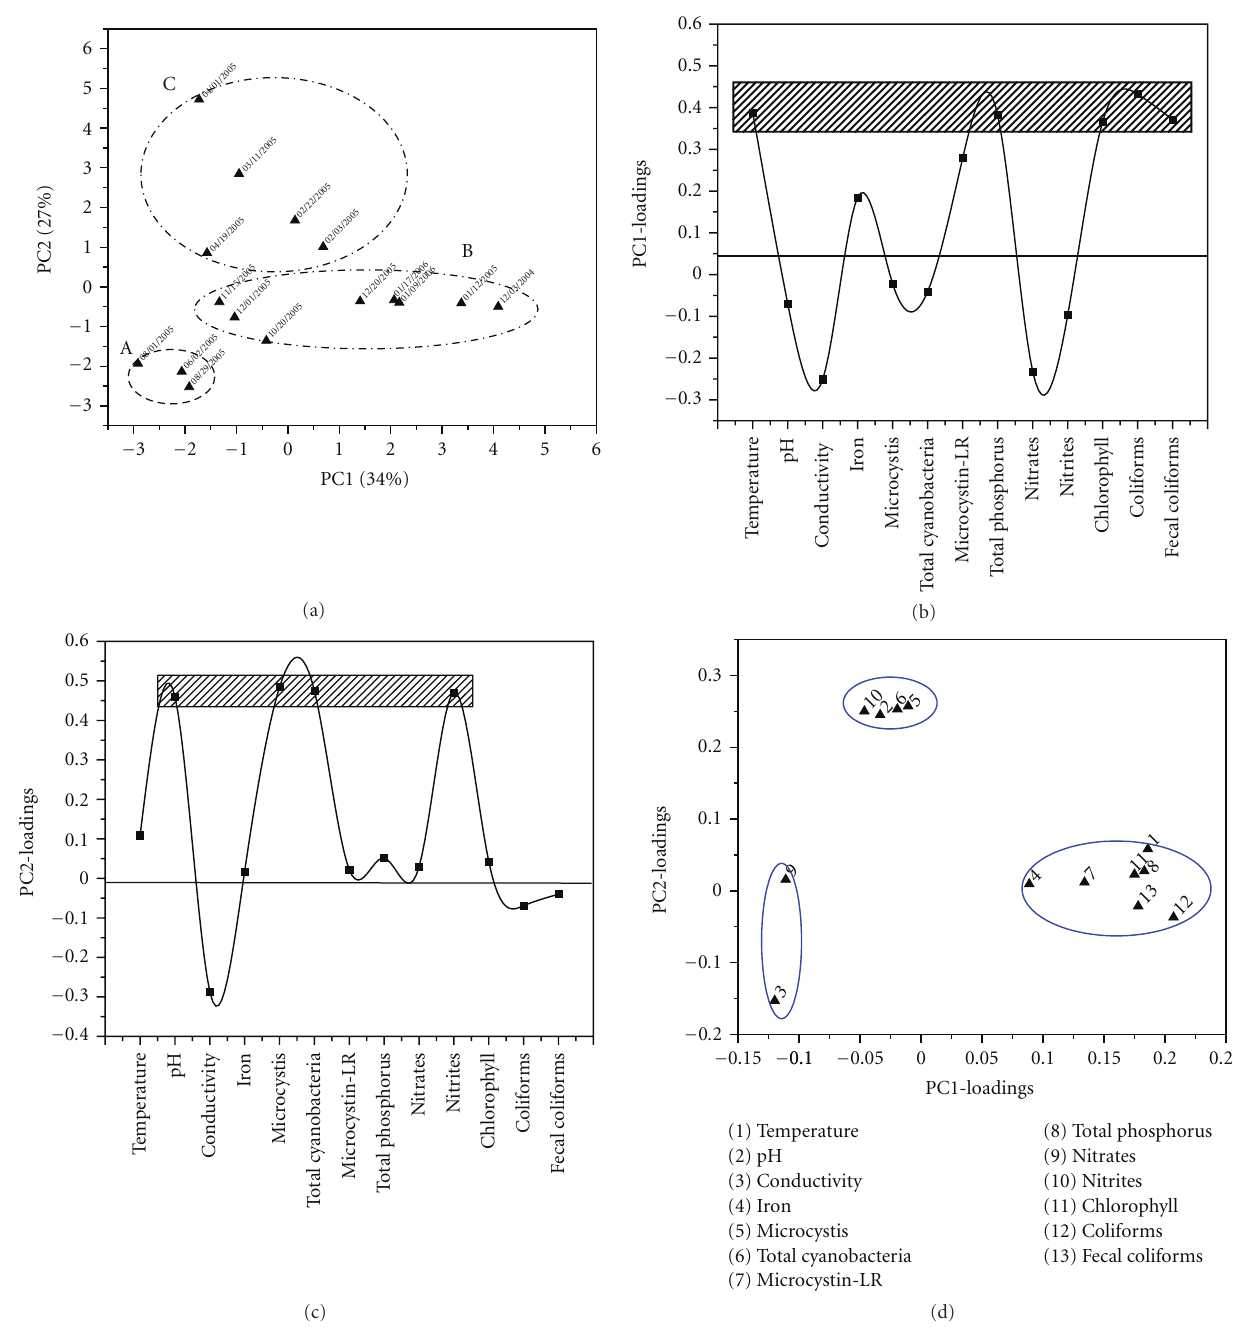
Figure 2: PCA results obtained for samples recollected from sampling point 1. (a) Two-dimensional PCA-scores plot for PC2 versus PC1, (b) and (c) correspond to one-dimensional loadings plots of PC1 and PC2, respectively, and (d) two-dimensional loadings plot.